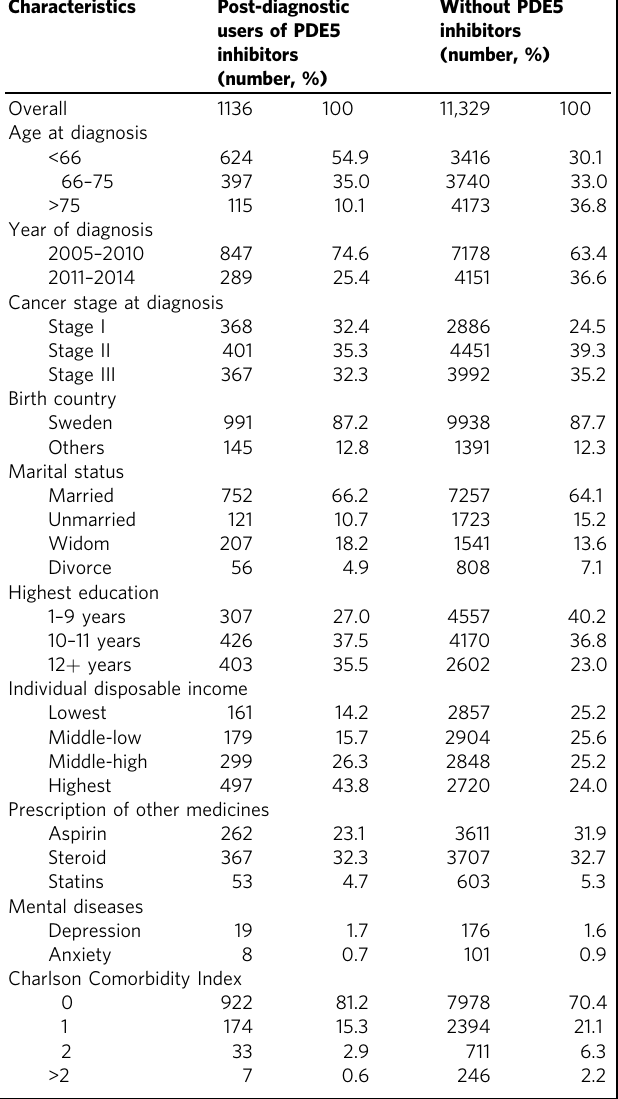
Table 1 Baseline characteristics of male patients with colorectal cancer.